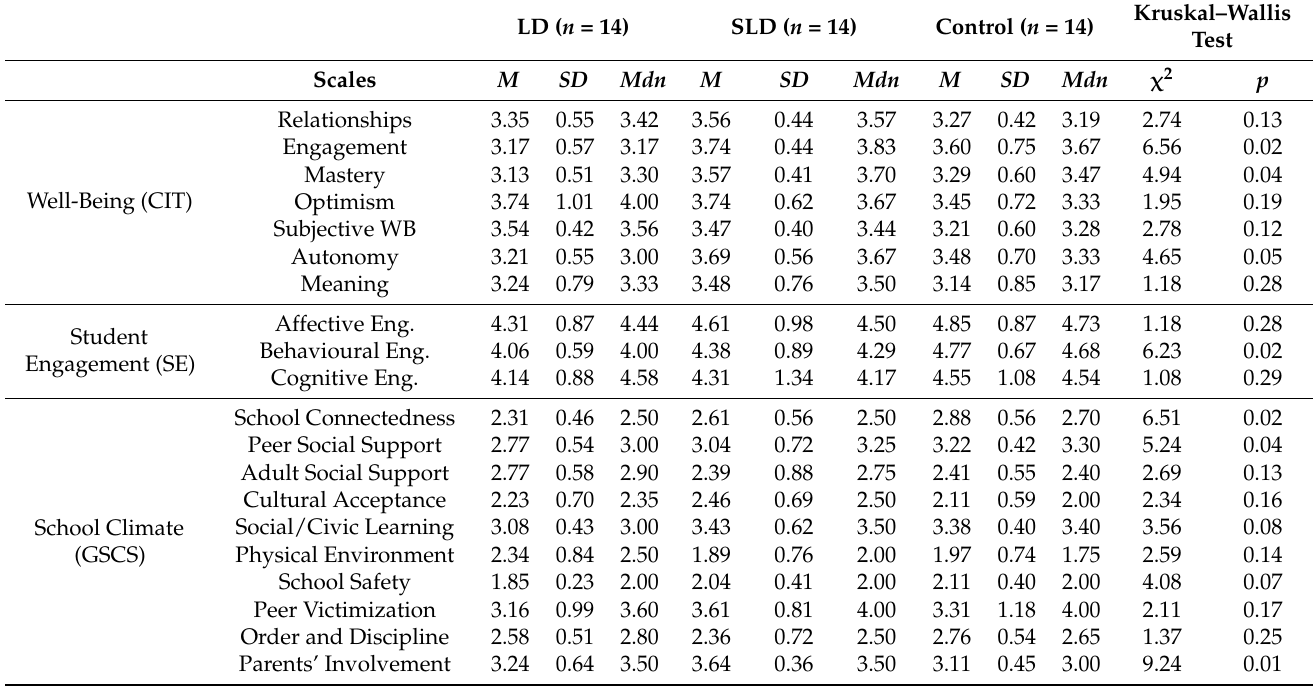
Comparisons between groups in engagement, well-being and perceived school climate scores, carried out through Kruskal–Wallis’ ANOVAs, showed the following results. As for well-being experience (CIT), data showed that there were significant differences between groups in the engagement [ χ 2 (2) = 6.56, p = 0.02, η 2 = 0.16], mastery [ χ 2 (2) = 4.94, Table 3, the scores were significantly higher for the SLD group than for the LD group on all the three scales: engagement [ U = 41.5, p = 0.004, ES = 1.01, 95% CI (1.85, 0.254)], mastery [ U = 49.5, p = 0.013, ES = 0.84, 95% CI (1.66, 0.107)], and autonomy [ U = 52.5, p = 0.017, ES = 0.81, 95% CI (1.591, 0.052)]. The scores were significantly higher for the control group than for the LD group only on the engagement scale [ U = 62, p = 0.047, ES = 0.68, 95% CI (1.387, 0.12)]. Table 3. Descriptive statistics and differences between groups (Kruskal–Wallis test) on well-being, student engagement, and school climate. Kruskal–Wallis LD ( n = 14) SLD ( n = 14) Control ( n = 14) Test Scales SD Mdn p Engagement Well-Being (CIT)